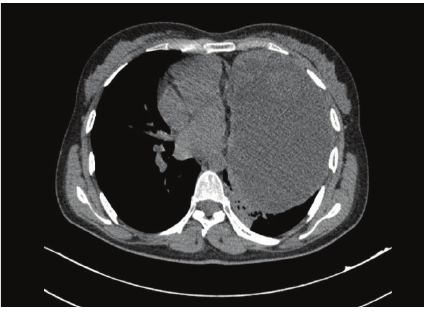
Figure 2: Control of chest X-ray after fluid evacuation.